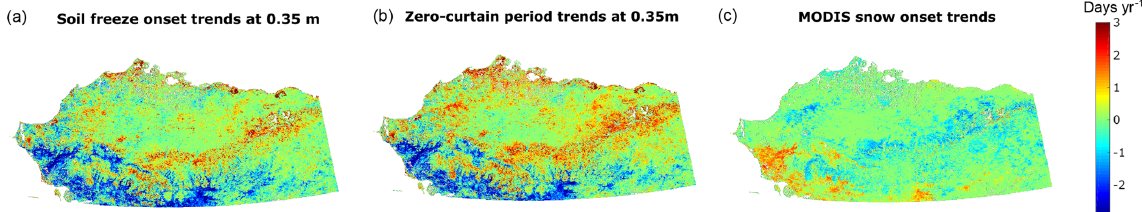
Figure 9. Trends in model-simulated soil freeze onset (a) and zero-curtain period (b) at 0.35m depth from 2001 to 2016. The fall snow onset trend for the same period derived from the MODIS SCE data is shown in (c)